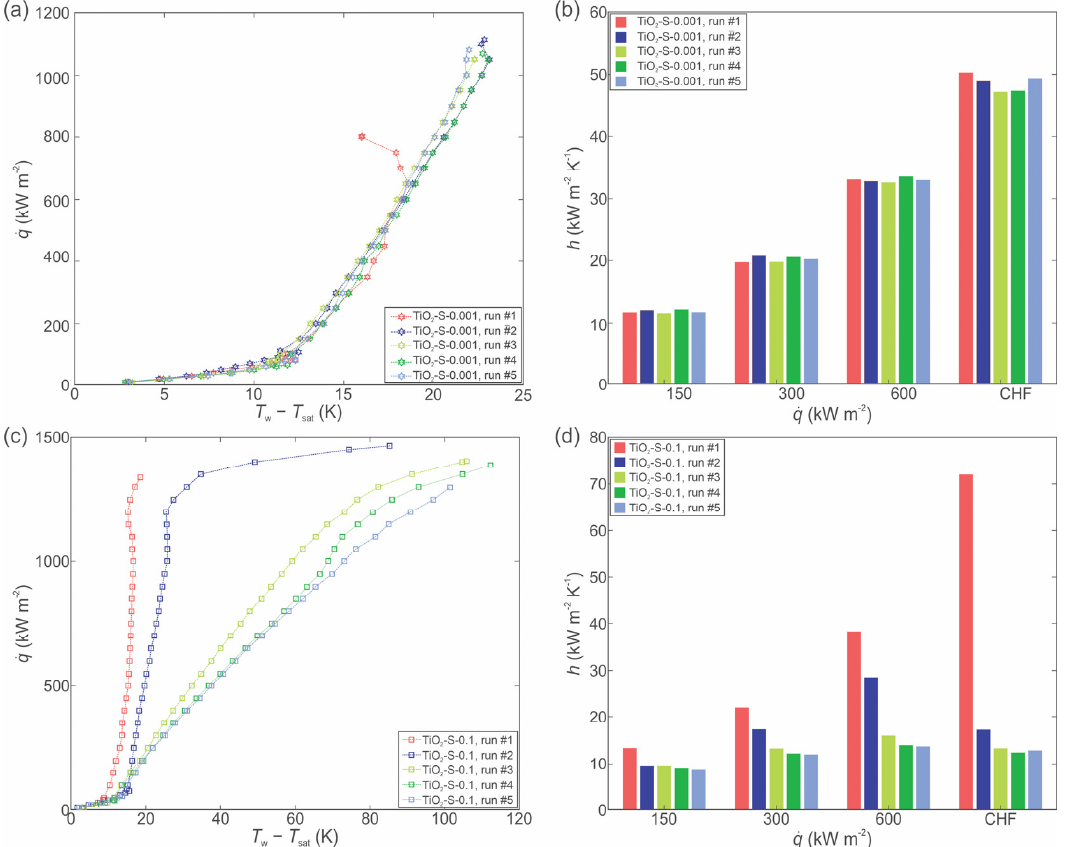
Figure 5. Boiling of TiO 2 -water nanofluid with small size nanoparticles at 0.001 wt.%: boiling curves ( a ) and heat transfer coefficients ( b ). Boiling of TiO 2 -water nanofluid with small size nanoparticles at 0.1 wt.%: boiling curves ( c ) and heat transfer coefficients ( d ).